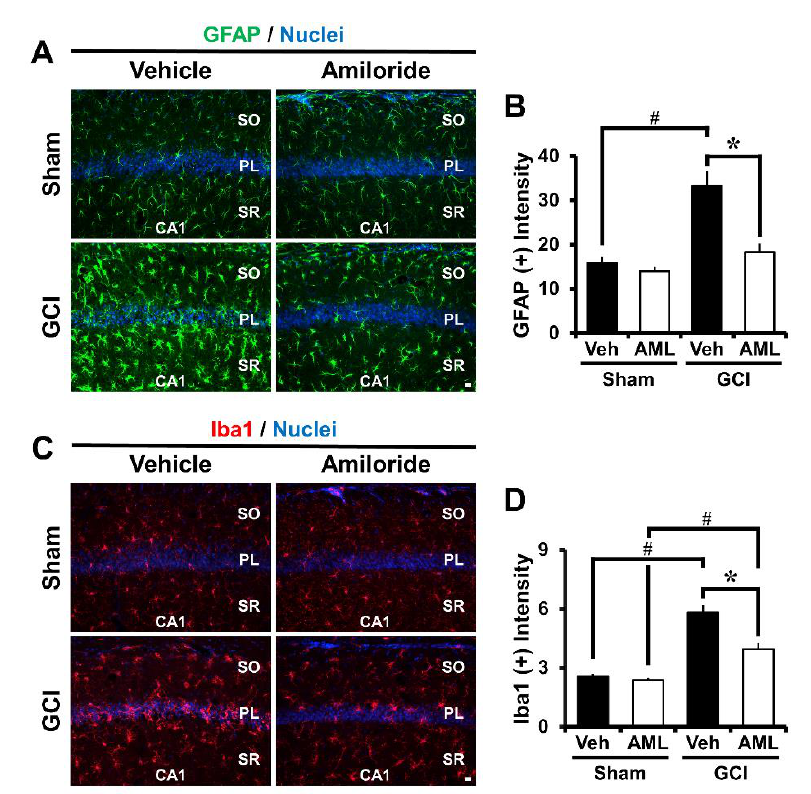
Figure 2. Amiloride treatment reduced astrocyte and microglial activation. GCI induces an inflammatory response by promoting astrocyte and microglia activation in the damaged brain. This figure shows astrocyte and microglia activation in the CA1 region 24 h after GCI. ( A , C ) show glial fibrillary acidic protein (GFAP) and Ionized calcium-binding adaptor molecule-1 (Iba-1) activation and ( B , D ) show GFAP and Iba-1 quantification in the CA1 region from sham-operated or GCI-induced mice. It was increased in the GCI-induced group compared with the sham-operated group. However, the amiloride-treated group showed reduced astrocyte and microglia activation after GCI. Scale bar = 20 μm. (Sham-vehicle, n = 5; sham-amiloride, n = 5; GCI-vehicle, n = 6; GCI-amiloride, n = 8). Data are mean ± SEM. * Considerably different from the vehicle-treated group, p < 0.05; # sham versus vehicle-operated group; sham versus vehicle-treated group, p < 0.05. (Kruskal–Wallis test (B) Chi square = 14.612, df = 3, p = 0.002; (D) Chi square = 18.606, df = 3, p < 0.001) (SO: stratum oriens; PL: pyramidal cell layer; SR: stratum lacunosum-moleculare).